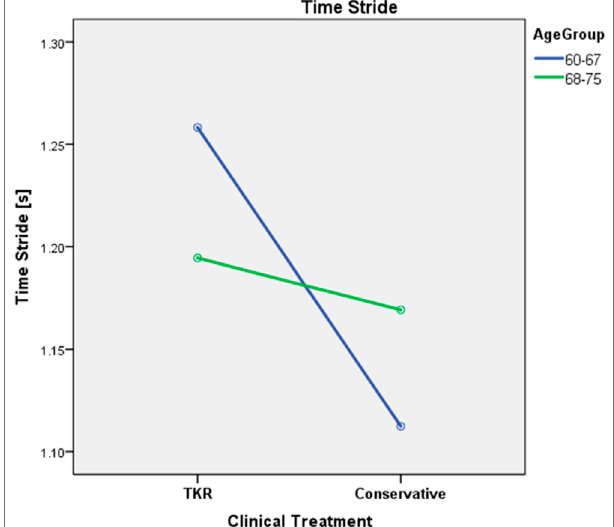
FIGURE 2 | Effect of the interaction between clinical treatment and age over mean stride time ( p = 0.006).